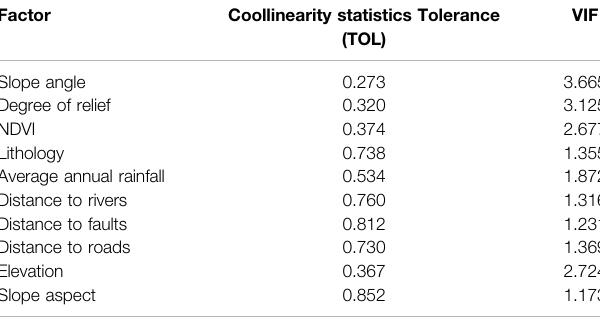
TABLE 3 | Multi-collinerity diagnostics of